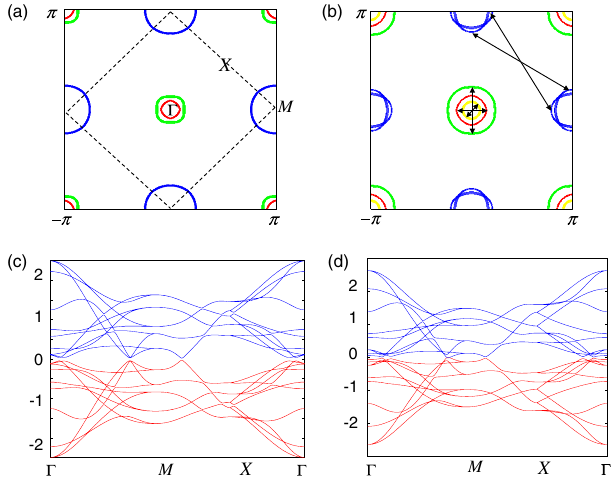
FIG. 5. The Fermi surfaces of a five-orbital model from [25] are shown in (a) and (b). The forms of the hopping terms and hopping parameters can be found in [25]. Here, we only add a chemical potential to tune the Fermi level. We set (cid:7) ¼ 0 : 1 and (cid:1) 0 : 04 in (a) and (b). We define the order parameters in Eq. (16) ¼ 1 ð (cid:1) N þ (cid:1) N Þ , (cid:6) o ¼ 1 ð (cid:1) N þ cos k cos k cos k as (cid:6) o x y y 11 ;n 22 ;n 11 ;x 11 ;y 11 ;x 2 2 Þ , (cid:6) o ¼ 1 ð cos k þ cos k Þ , (cid:6) o ¼ (cid:1) NN cos k (cid:1) N sin k sin k , (cid:1) N x x y x y 11 ;y 44 ;n 44 12 ;(cid:1) 12 2 ¼ (cid:1) NN cos k cos k . The high-symmetry points are and (cid:6) o x y (cid:4)(cid:4);(cid:1) (cid:4)(cid:4) shown in (a), and the pairing channels connecting the points on the Fermi surface are denoted by the black lines with arrows. and (b) are shown in (c) and (d). We find that in (c) the spectrum is fully gaped, and (d) has nodes at the electron